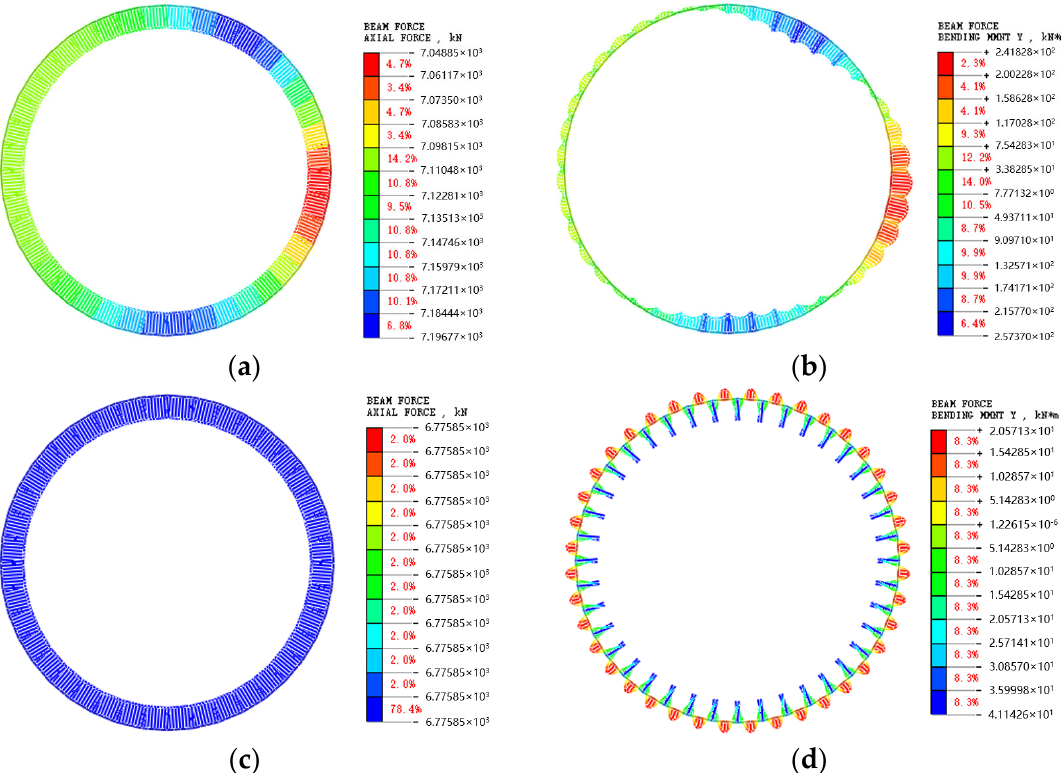
Figure 22. Simulated internal force of S1ZK0 + 660 m section. ( a ) Non ‐ uniform axial force diagram; ( b ) Non ‐ uniform bending moment diagram; ( c ) Uniform axial force diagram; ( d ) Uniform bending moment diagram.